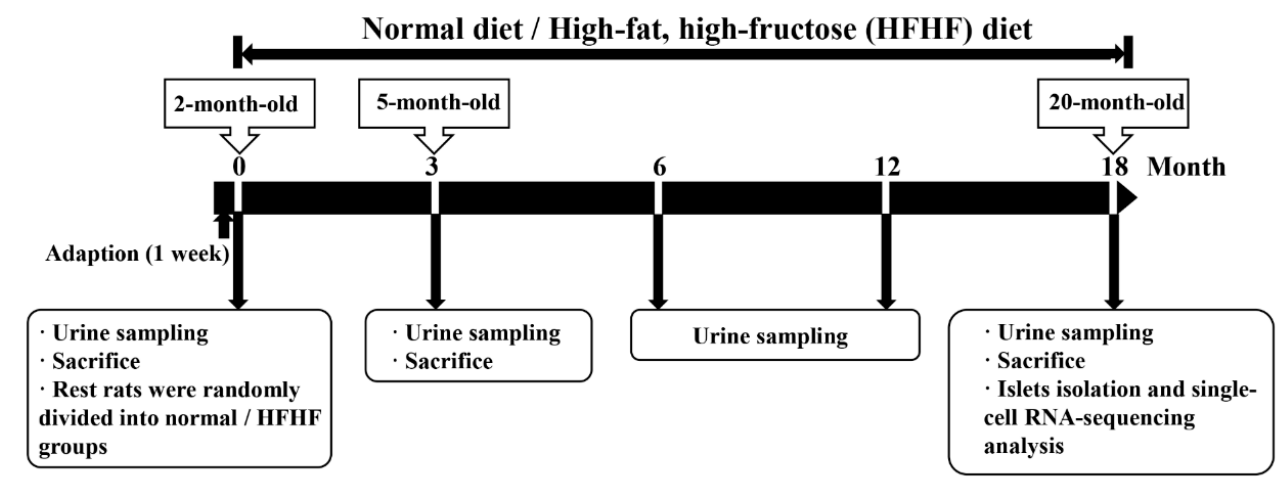
Figure 1. The study